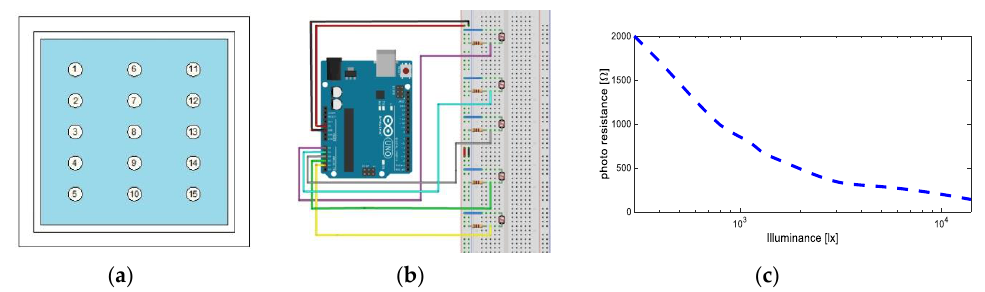
Figure 12. The fifteen positions in which the sensors were placed inside the glass block and corresponding photo-resistance and illuminance curve. Photosensitive sensor HW5P-1 Shenzhen Haiwang Sensor Co: ( a ) the used 3 × 5 matrix of photo-resistors; ( b ) Arduino scheme for the first column; ( c ) photo-resistance / illuminance curve.